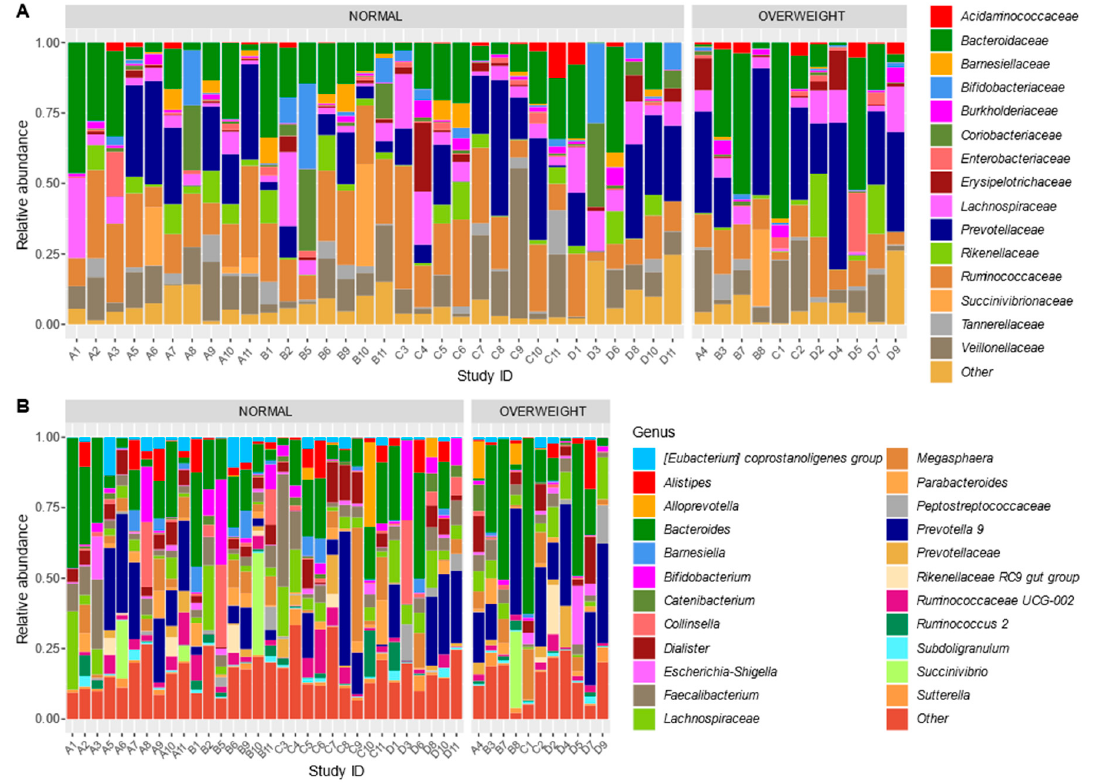
Figure 4. Relative abundance profiles at family ( A ) and genus ( B ) level. The category ‘Other’ indicates the sum of all other families or genera per sample.